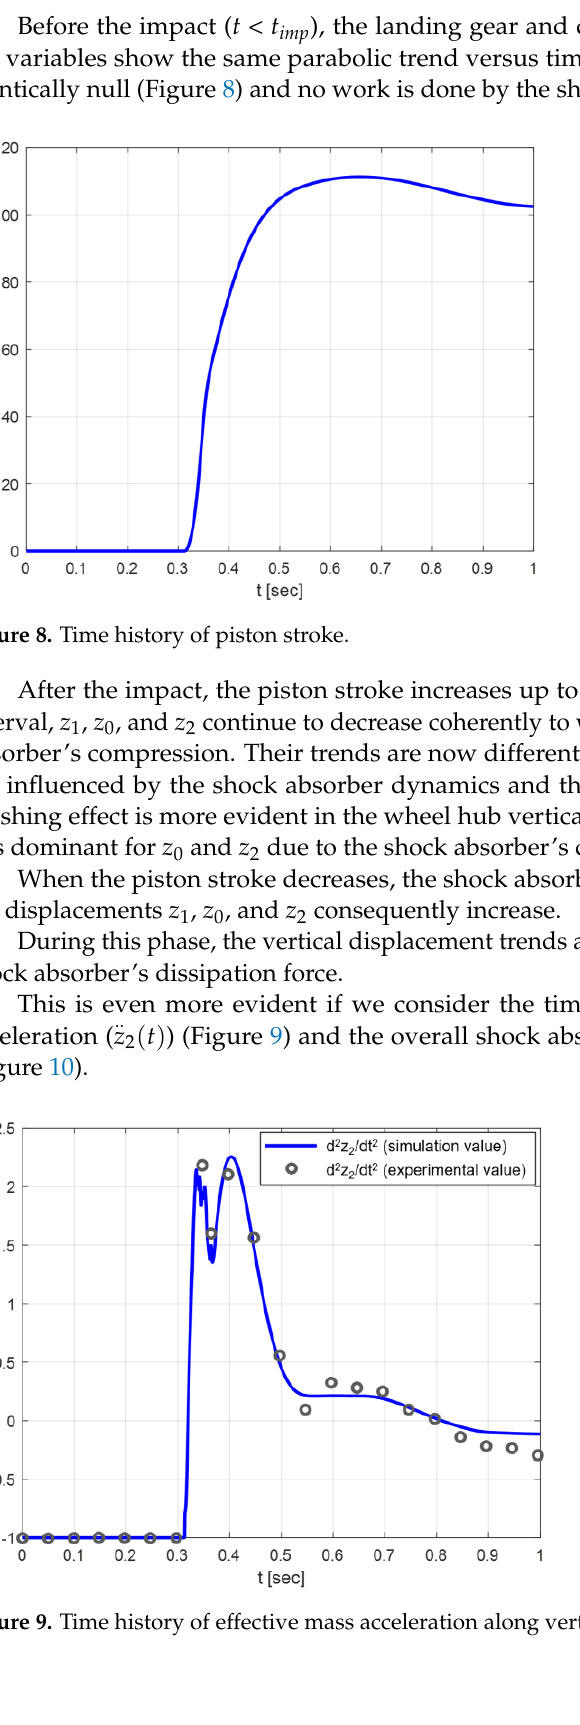
Figure 7. Time histories of vertical displacements z 1 , z 0 , and z 2 .